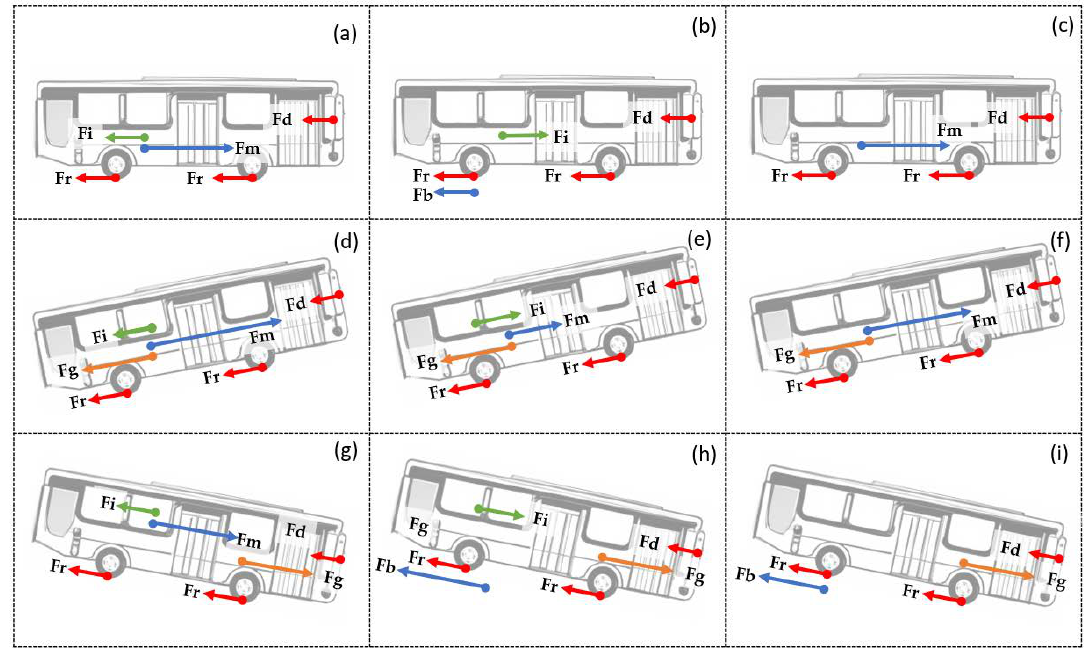
Figure 2. ( a ) Vehicle accelerating in flat terrain; ( b ) Vehicle decelerating in flat terrain; ( c ) Vehicle in constant speed in flat terrain; ( d ) Vehicle accelerating uphill; ( e ) Vehicle decelerating uphill; ( f ) Vehicle in constant speed uphill; ( g ) Vehicle accelerating downhill; ( h ) Vehicle decelerating downhill; ( i ) Vehicle in constant speed downhill.